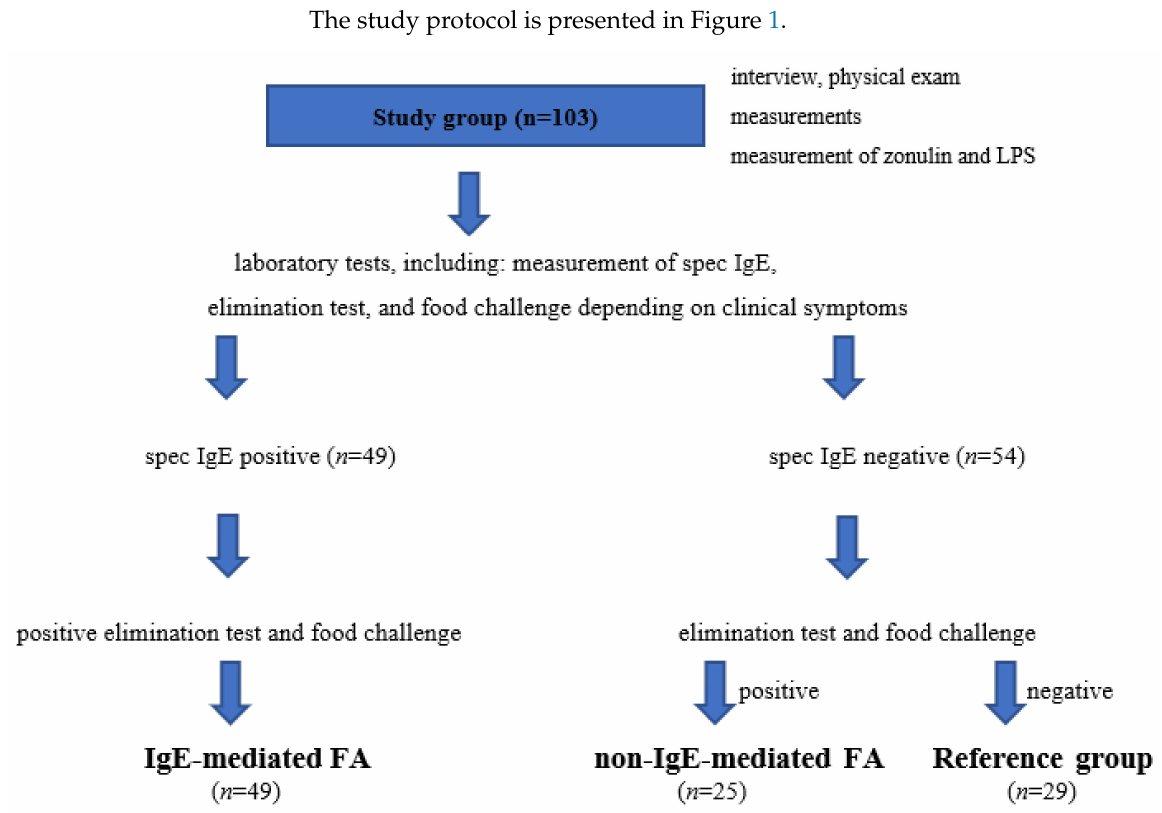
Figure 1. Study protocol and allocation of patients to the study and reference groups. FA, food allergy; LPS, bacterial